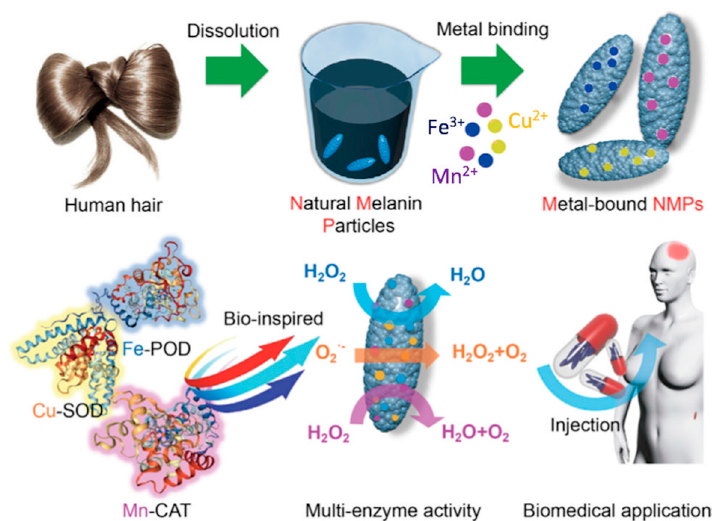
Figure 4. Enzyme mimicking activity of metal ions-doped melanins for various biomedical applications. Reproduced with permission from [53]. Copyright Cell Press, 2020.